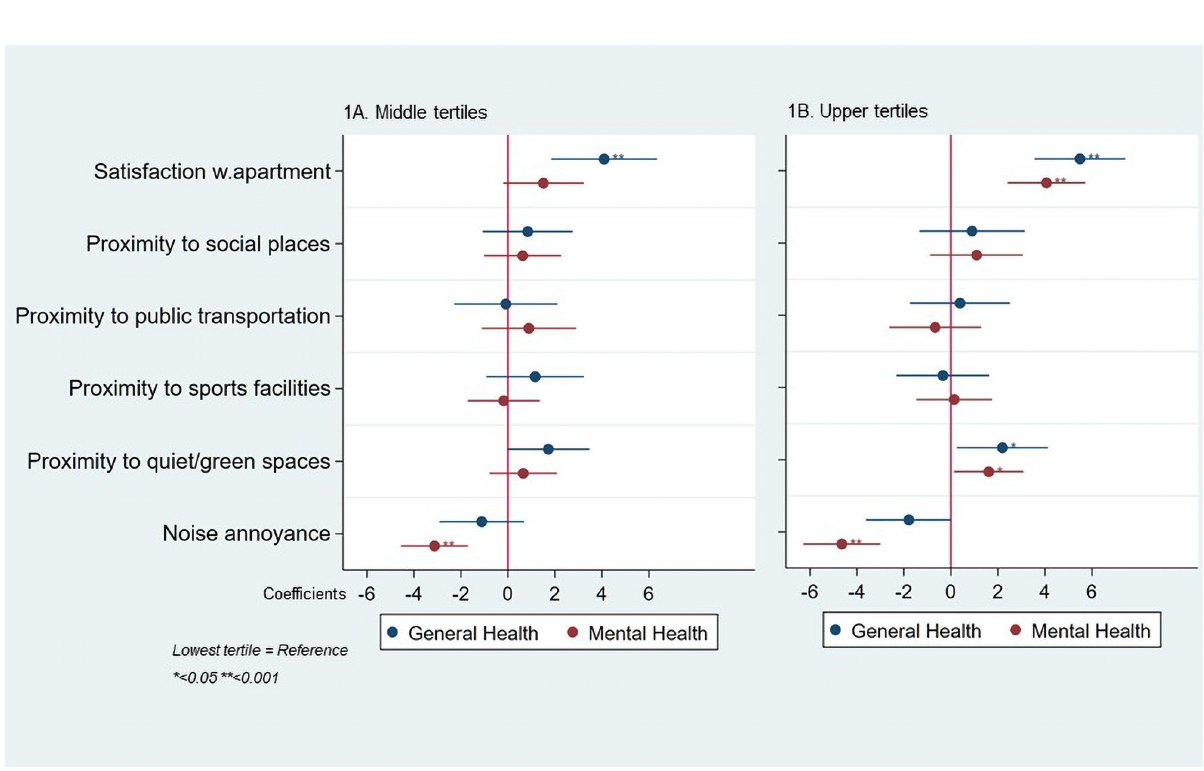
Fig 1. Association of variables describing the perceived built environment categorized as tertiles (1A = Middle tertiles; 1B = Upper tertiles) with health-related quality of life domains, adjusted for covariates (sex, age, education, smoking status, occupational status and study area).